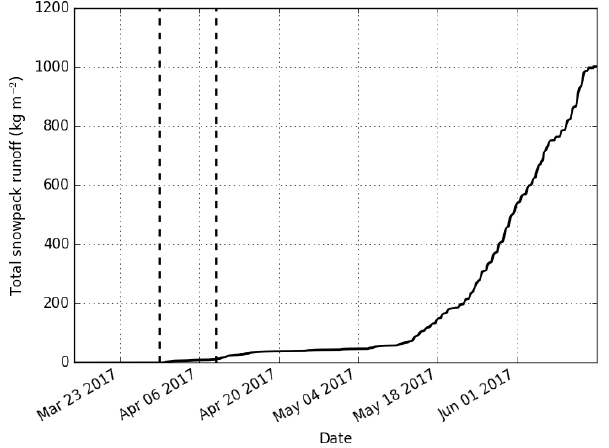
Figure 5. Total snowpack runoff from 15 March to 15 June 2017 at WFJ. Dashed lines indicate 30 March and 9